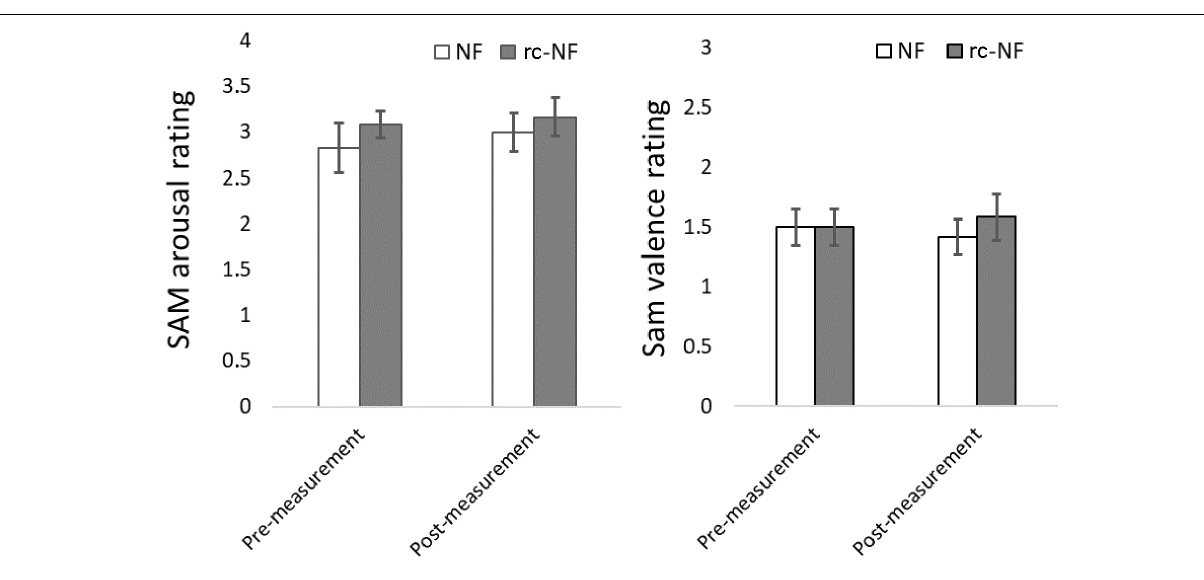
Frontiers in Neuroscience |